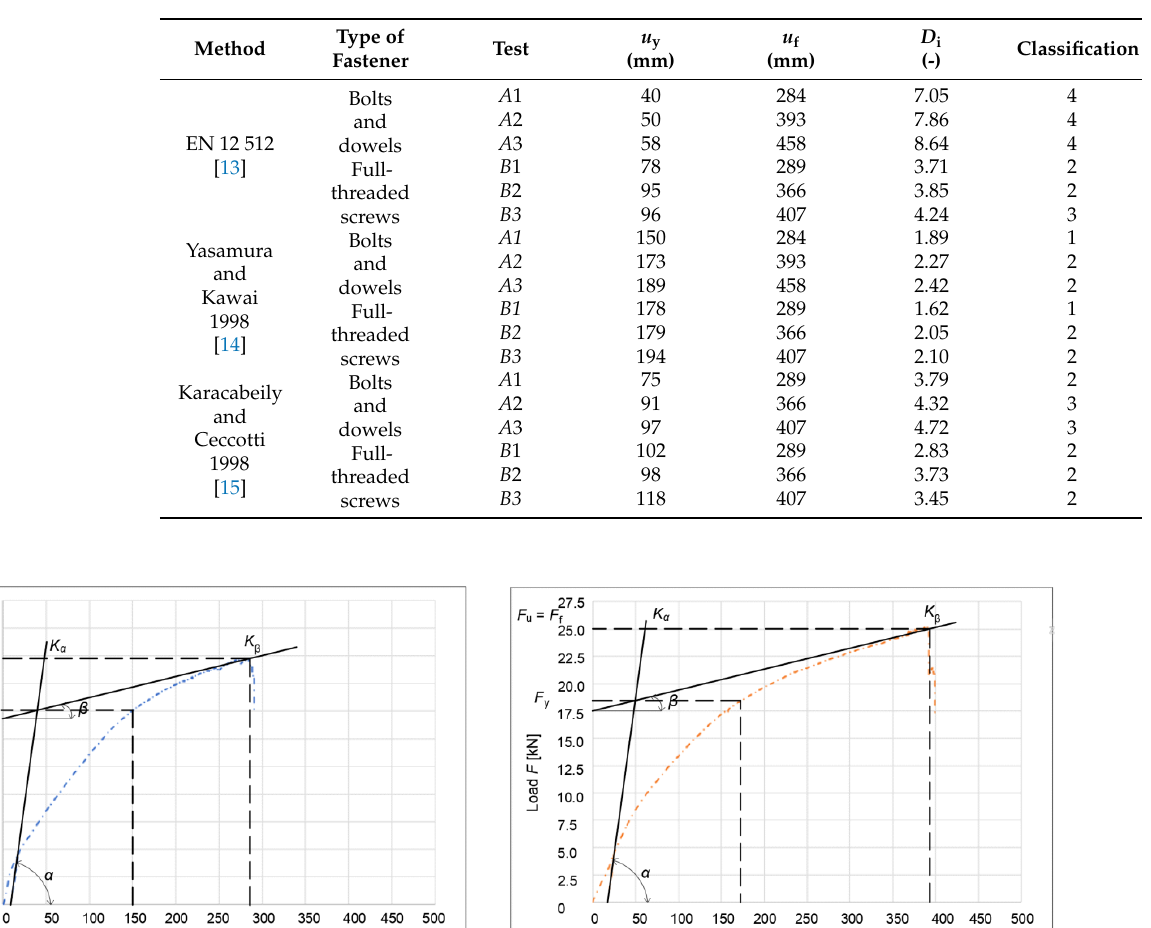
Table 8. Comparison of ductility results of experiments.